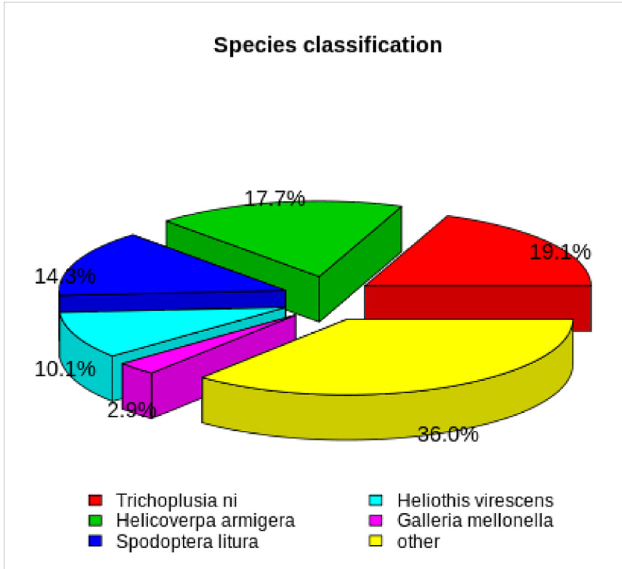
FIGURE 1 Homologous species distribution of H. cunea annotated in the NR database.